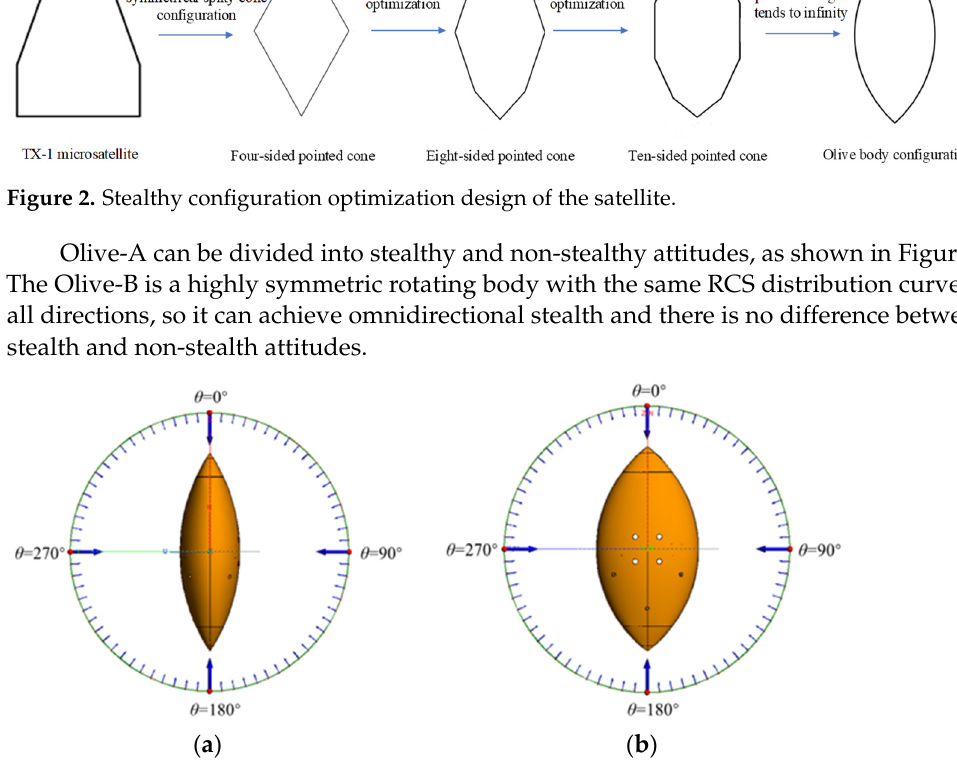
( b ) Figure 4. Comparison of RCS in different attitudes of the Olive-A configuration. ( a ) Comparison of RCS distribution. ( b ) Comparison of mean and maximum values of RCS. To verify the feasibility of the optimization method in Figure 2, the central frequency point of the X-band is selected to analyze TX-1, the eight-sided pointed cone, the ten-sided pointed cone, and the stealth attitude of Olive-A configuration. The comparison of the RCS numerical calculation results of the four stealth configurations at the X-band (10 GHz) is given below. From Figure 5 and Table 2, it is easy to find that the pattern is very obvious in the X- band; the stealth performance of the four configurations is Olive > ten-sided cone > eight- sided cone > TX-1, both in terms of RCS mean and RCS maximum. The arithmetic mean and maximum values of RCS of the Olive configuration are lower than those of the TX-1 by 3.65 dB and 43.97 dB, respectively, while the RCS reduction in the ten-sided cone is better than that of the eight-sided cone. This again confirms the correctness and feasibility of the optimized design method in Figure 2. In addition, the RCS distribution of the Olive configuration is very gentle in the symmetric angular domain centered at 90° and 270°, while the RCS curves of the other three configurations oscillate strongly and have more scattering peaks, which is extremely unfavorable for the stealthy configuration design. 0